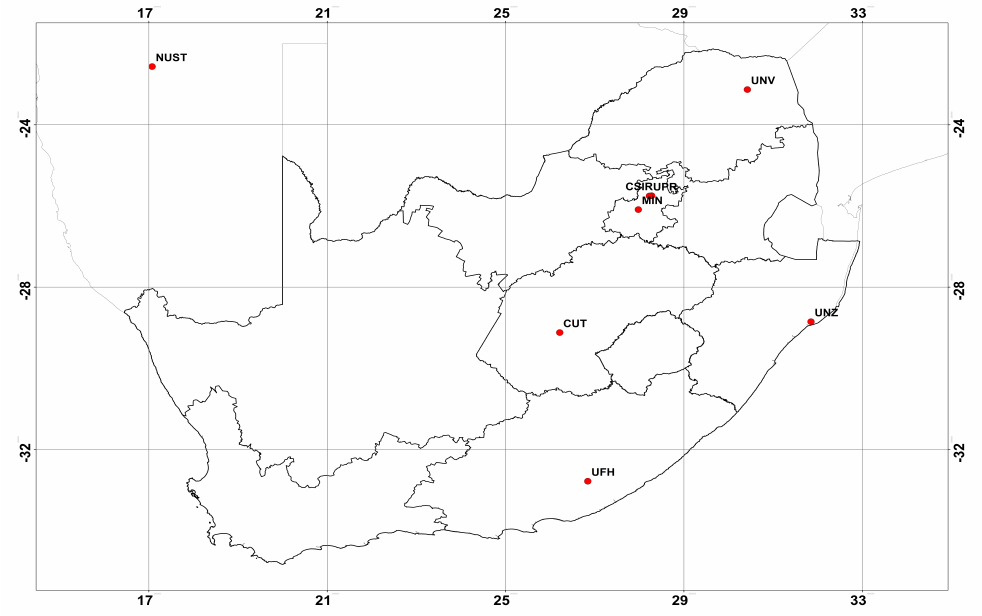
Figure 2. Map showing radiometric stations. Source: Author’s creation.